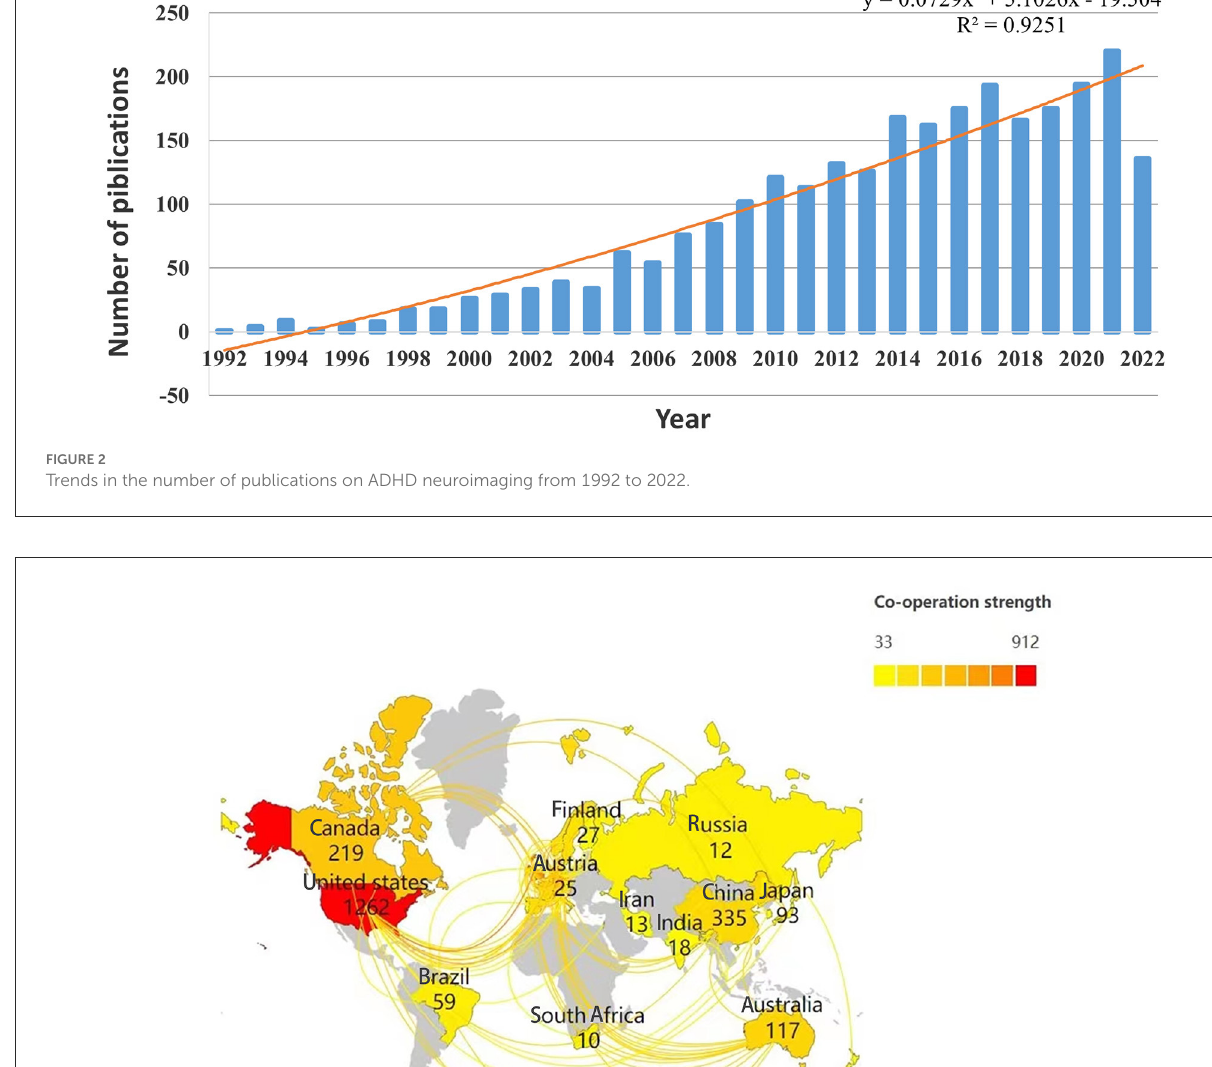
United States (0.28), England (0.17), and Italy (0.16). These three countries are influential in the field of ADHD